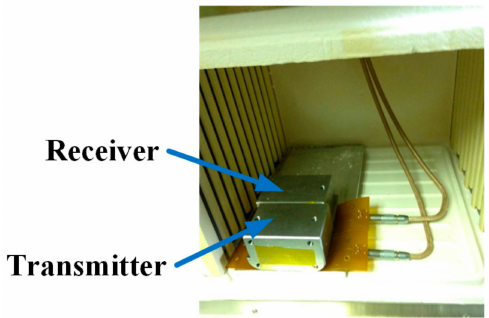
Figure 5. Temperature testing setup with EMATs placed side-by-side on an aluminum alloy